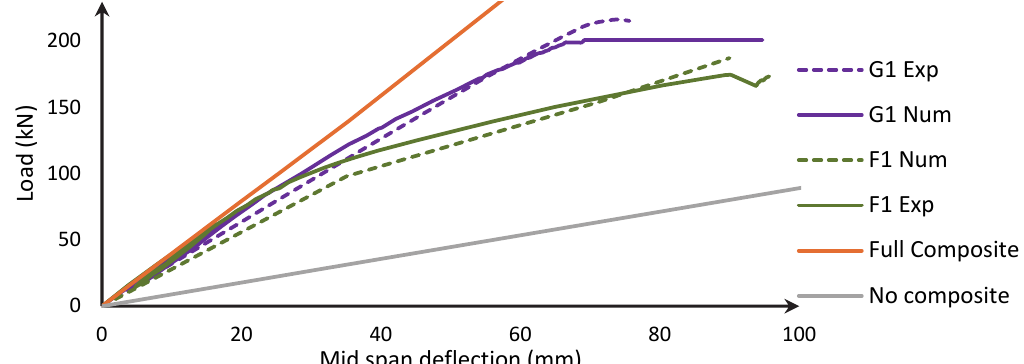
Figure 12: The load-mid-span deflection curves of the TCC beams F1 and G1 compared with the experimental curves . A general comparison of the bending stiffness K TCC and the maximum load are reported in Tab. 5: